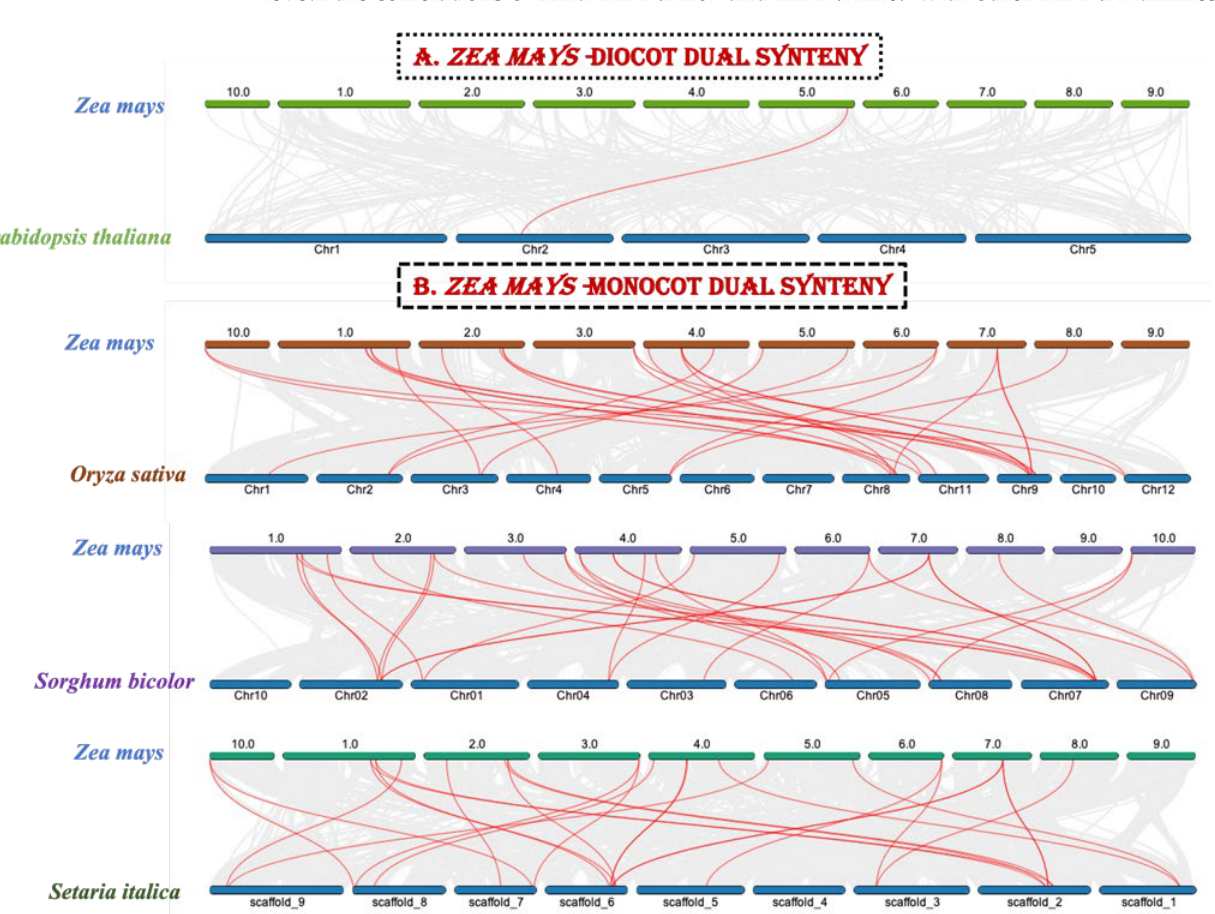
Figure 6. Synteny analysis of the maize genome with one monocot ( A ) and three dicot ( B ) plant genomes. The gray lines represent aligned blocks between the paired genomes, and the red lines indicate syntenic ZHD gene pairs. We performed both dual synteny and specific gene family synteny analyses for the maize genome, this being one of the most important fields in comparative genomic analysis, as it is the basis of evolutionary studies at both the gene and genome levels. We used the species-specific gene family protein sequences, but not in the synteny analysis, as most of the causes have not been properly studied, for instance, the chromosomal gene positions are quite enigmatic. Insofar as we could find well-researched sequences online, we retrieved and dual-synteny-analyzed them. In addition, a specific gene family from the maize genome synteny analysis was studied to comprehend duplication occurrences and internal evolutionary